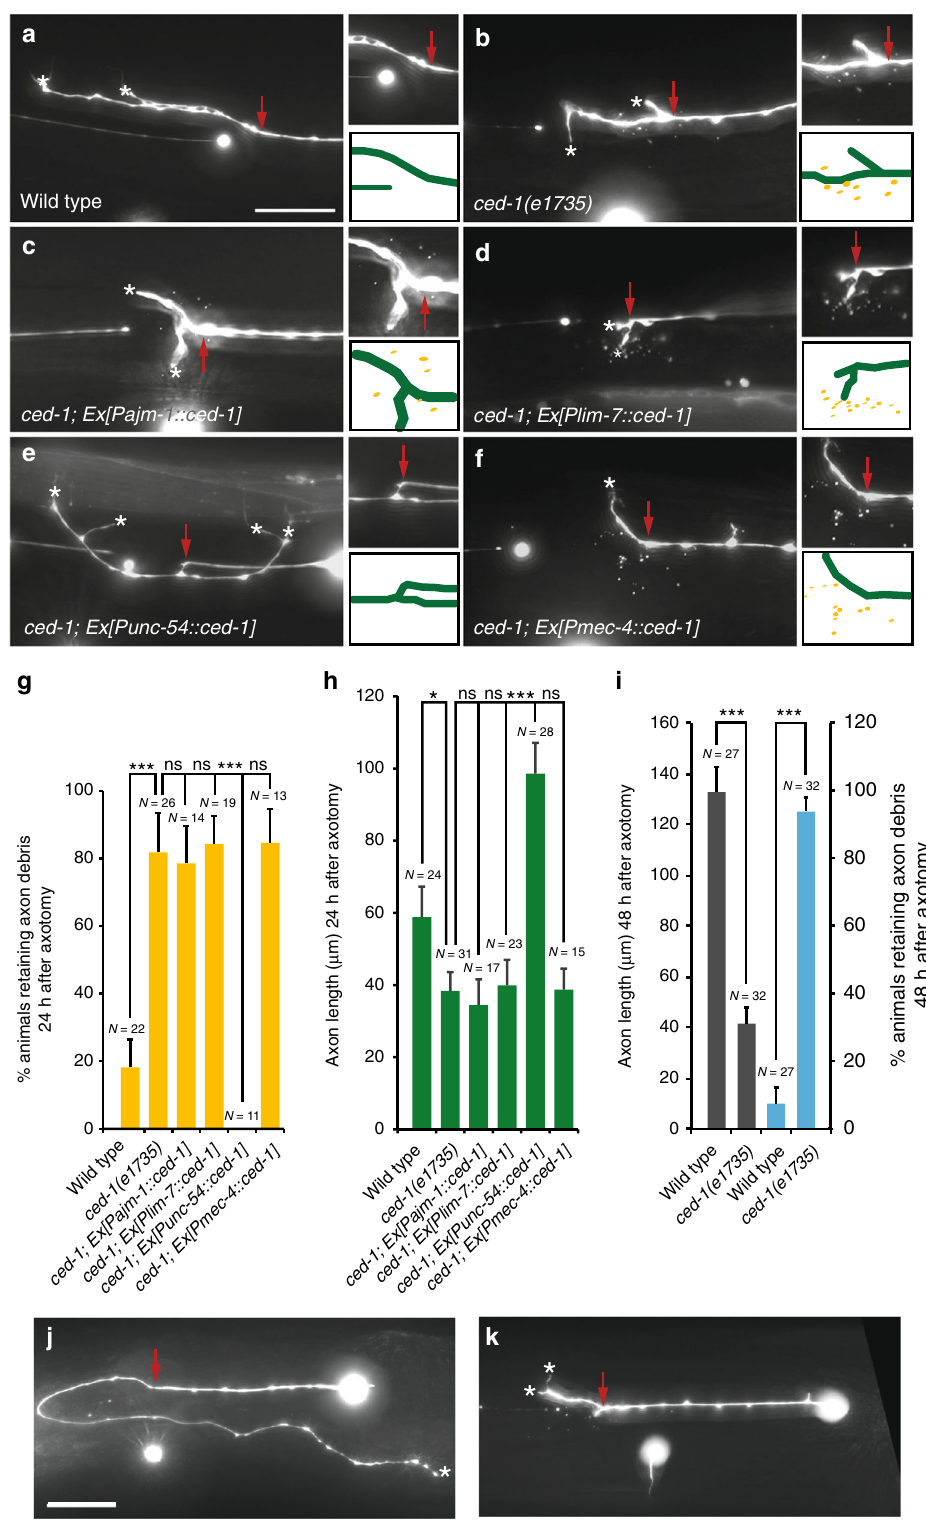
cue, LECT-2. In sax-7 mutants, PVD dendrites fail to extend to axons instead project anteriorly and adopt a lateral position skin cells (Fig. 4e). Expression of CED-1 in body wall muscles (Fig. 4b). Expression of CED-1 in body wall muscles redirected redirected PVD dendrites in sax-7 mutants to muscles (Figs. 4f, g; AVM axons in unc-6 mutants to muscles (Fig. 4c; % AVM axons % PVD dendrites redirected to muscles = 100%, n > 30). redirected to muscles = 100%, n > 30). In wild-type animals, PVD Together, these results further support a role of CED-1 in dendrites are guided to skin cells (Fig. 4d) due to combined effects muscles as an adhesion molecule to neurites. of two skin cues, SAX-7 (L1CAM) and MNR-1, and one muscle NATURE COMMUNICATIONS| (2018) 9:4842 |DOI: